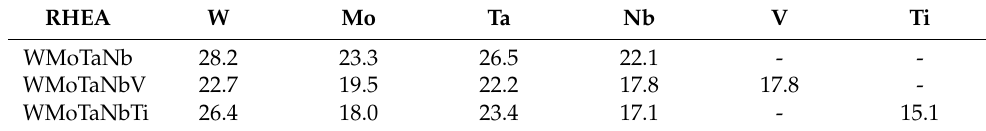
Table 1. Chemical composition of the three alloys measured by EPMA (in at.%). RHEA W Mo Ta Nb V Ti WMoTaNb 28.2 WMoTaNbV 22.7